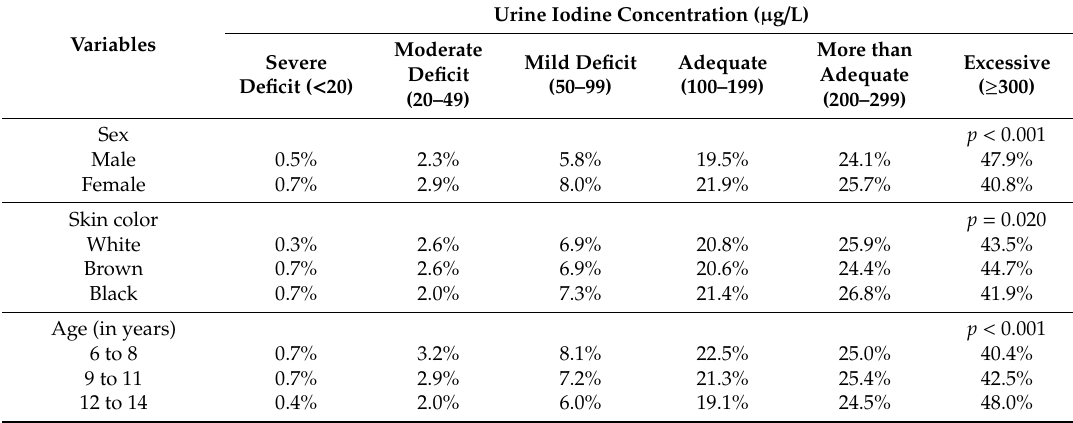
Table 5. Urine iodine concentration ( µ g / L) according to characteristics of schoolchildren aged 6 to 14 years, Brazil,